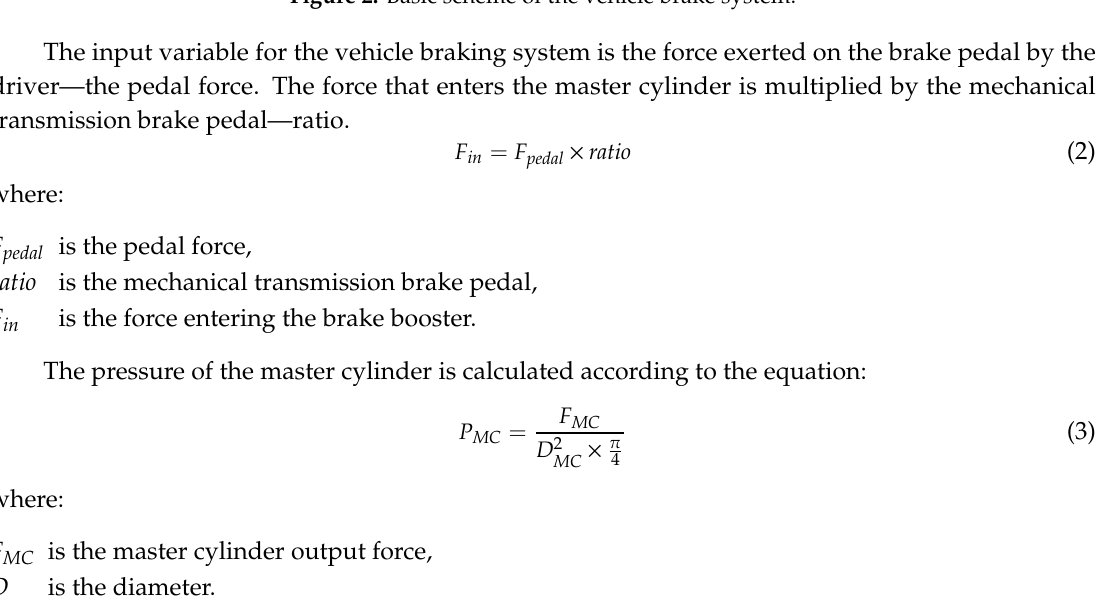
Figure 2. Basic scheme of the vehicle brake system.